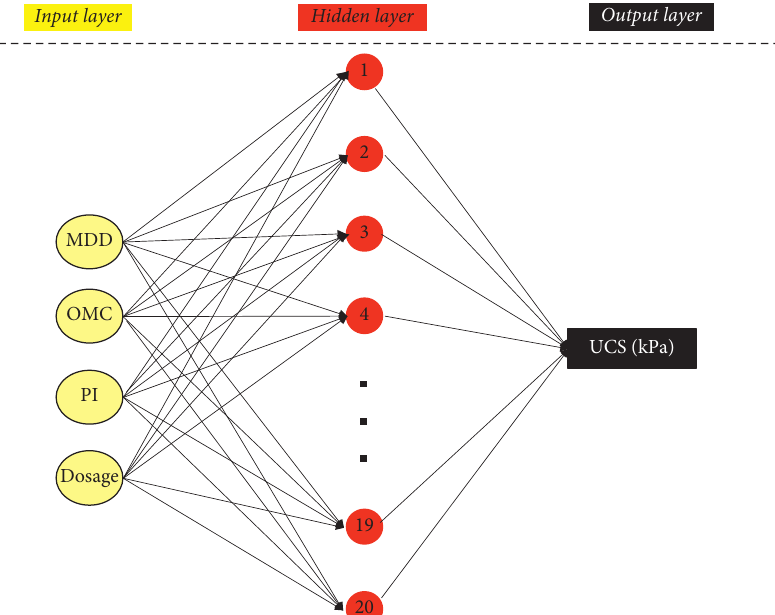
Figure 8: Artificial neural network (ANN) model configuration.